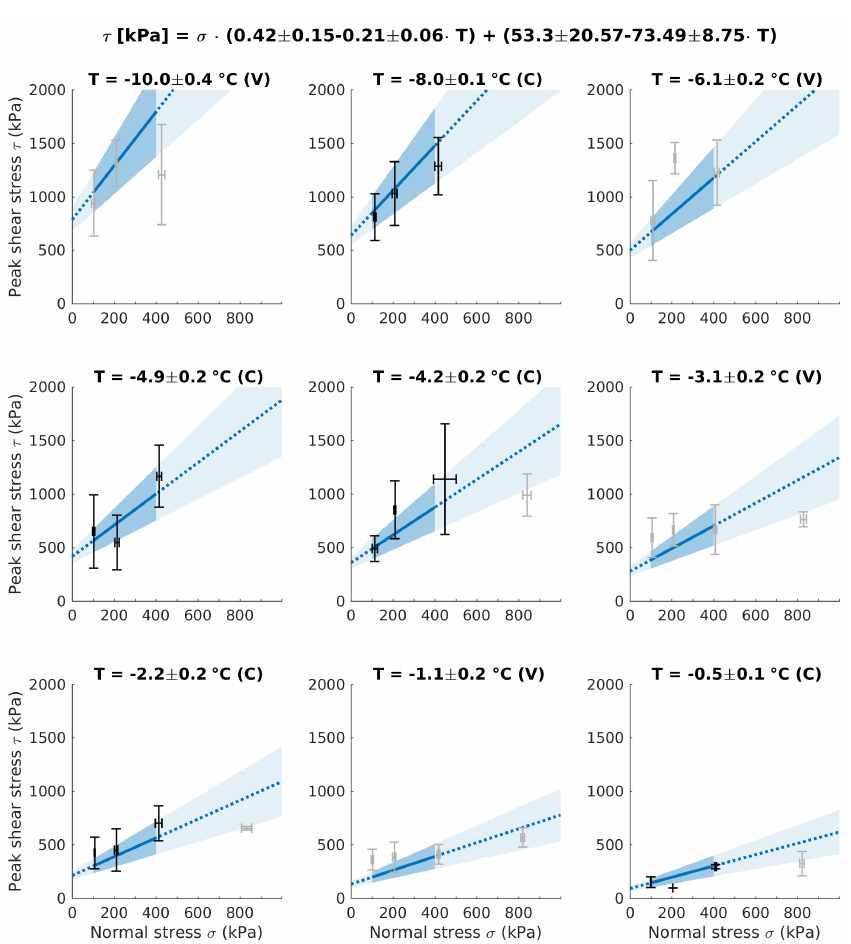
Figure 9. Validation test for the new Mohr–Coulomb failure criterion for ice-filled rock joints (Eq. 6). The black and grey crosses represent means and standard deviations of normal stress and peak shear stress, grouped by the tested normal stress classes 100, 200, 400 and 800kPa. C : calibration temperature level that was used for the model as p ≤ 5% (black crosses). V : validation temperature level that was excluded from the elaboration of the failure criterion because p > 5% (grey crosses). As tests at 800kPa were excluded from the development of the failure criterion, they also serve as validation (grey crosses). Solid blue lines and dark blue areas represent the calculated failure criterion and respective error ranges within the valid normal stress range. Dotted blue lines and light blue areas are extrapolations of the failure criterion and error margins beyond the valid normal stress